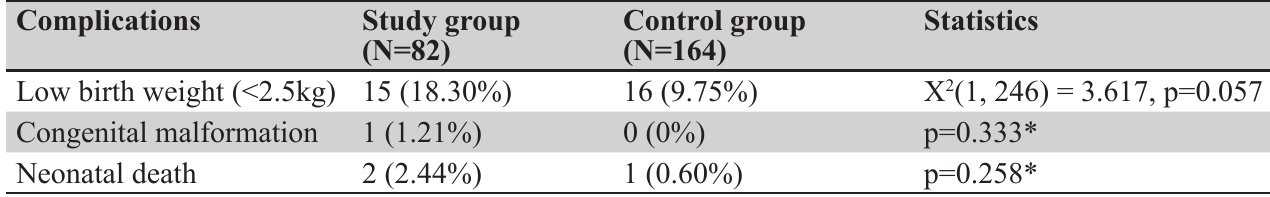
Table 4. Comparison of neonatal outcome in the study and control